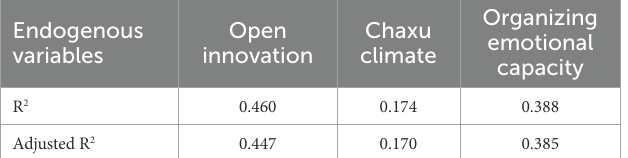
TABLE 4 R 2 values for each dependent